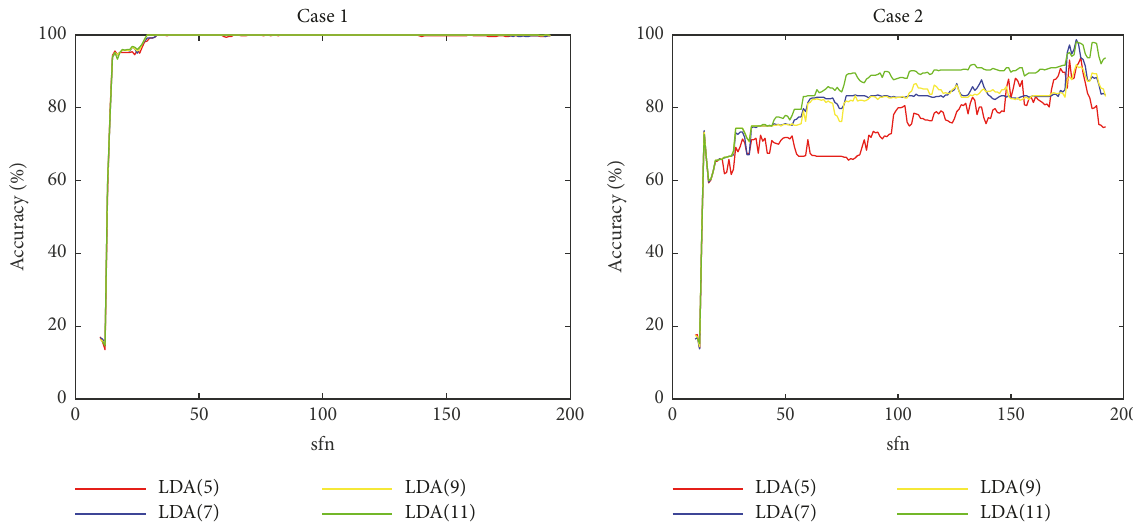
Figure 16: The diagnosis results obtained by OFS-FSASD-LDA-SVM using MODWPT with different dimension sizes for LDA. The LDA (5) represents that the number of dimension sizes is